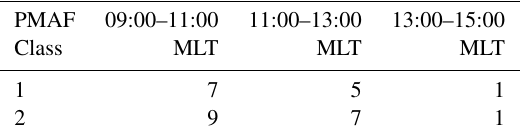
Table 2. Number of PMAFs broken down by class and occurrence time under IMF B y > 0. This table includes all PMAFs from both event lists that occurred under duskward IMF and for which there is adequate ASC data coverage to determine PMAF